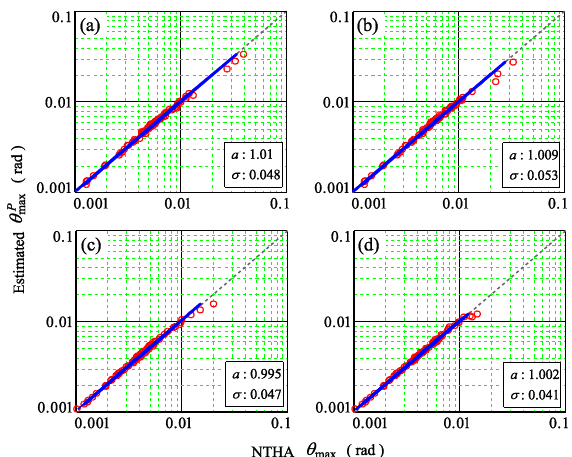
Figure 5. Regressions of θ max on θ P max for a three-story frame with dampers: ( a ) κ = 1.5 and υ = 0.4; ( b ) κ = 1.5 and υ = 0.6; ( c ) κ = 3 and υ = 0.4; and ( d ) κ = 3 and υ = 0.6. Appl. Sci. 2017 , 6 , 449 12 of 15